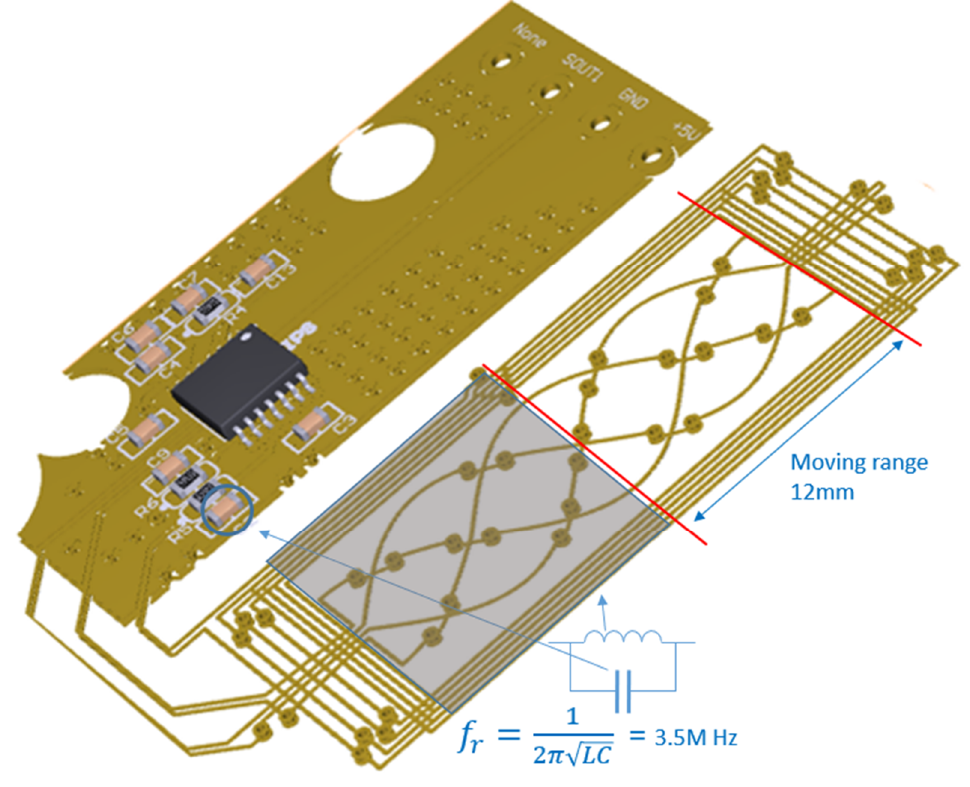
Figure 9. Inductive long-stroke position sensor with metal target size (blue square) and actual target moving range 12 mm.